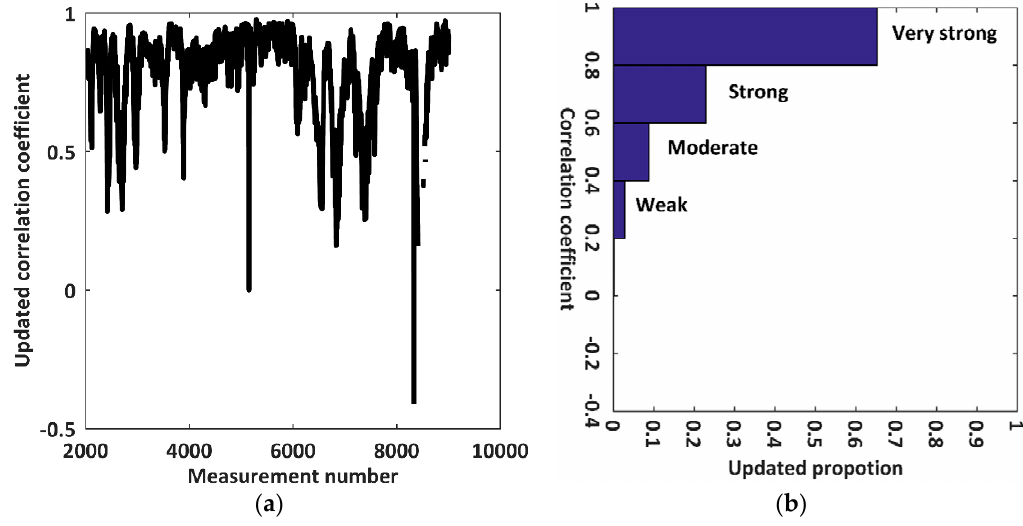
Figure 10. ( a ) The updated correlation coefficients of CHP derived from Tomoradar and LiDAR data; and ( b ) the updated proportions of correlation coefficient, when Tomoradar footprint cone is 20 degrees.